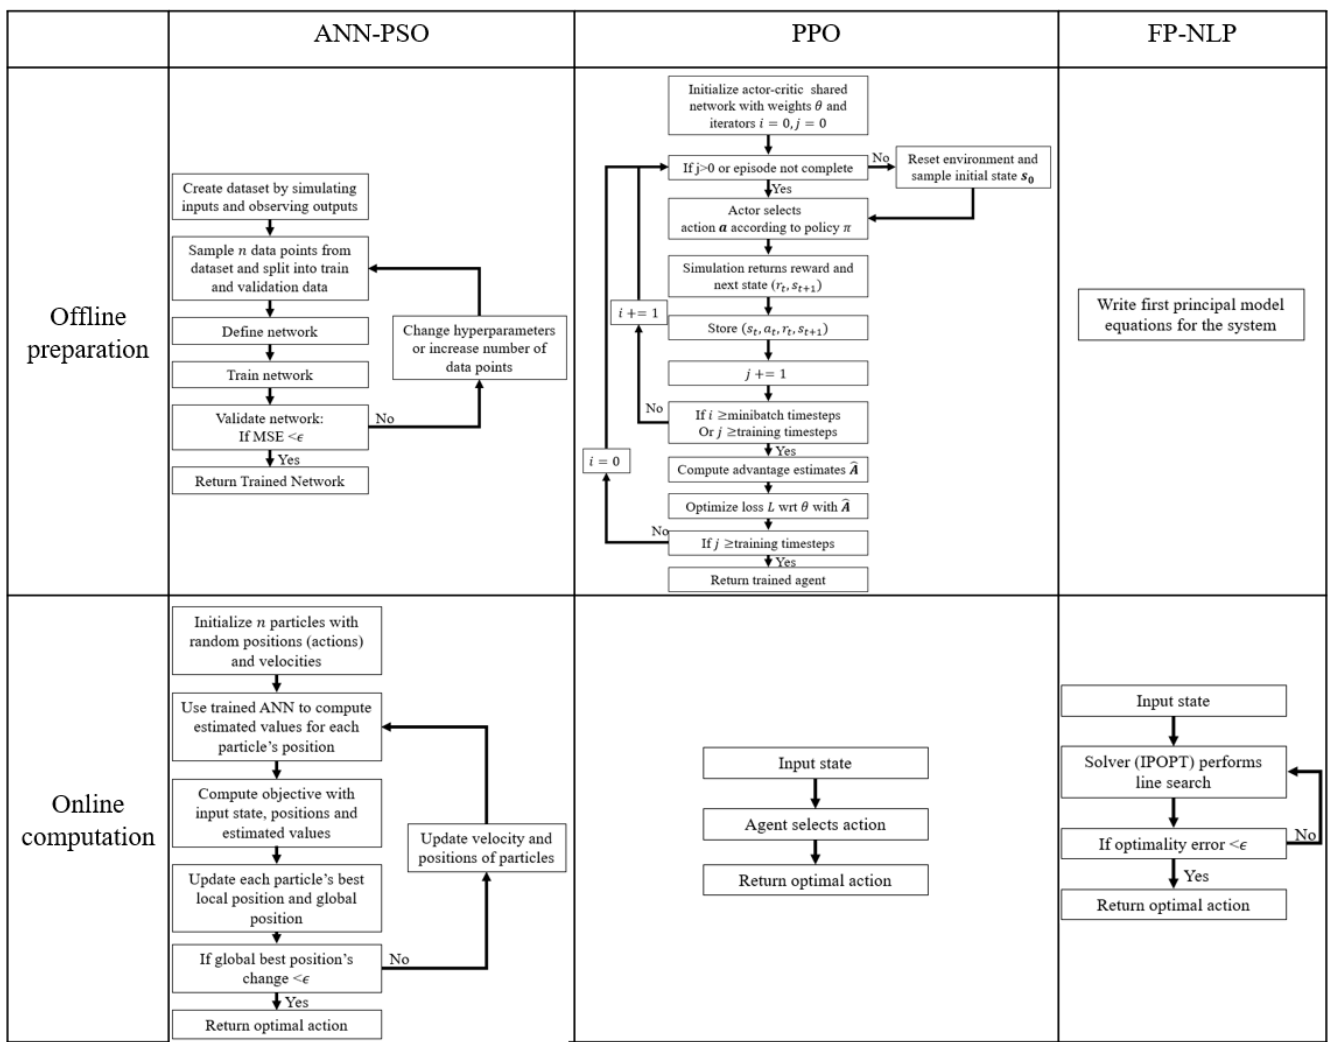
Figure 2. Algorithm flow chart for offline preparation and online operation of a steady state system ( γ =